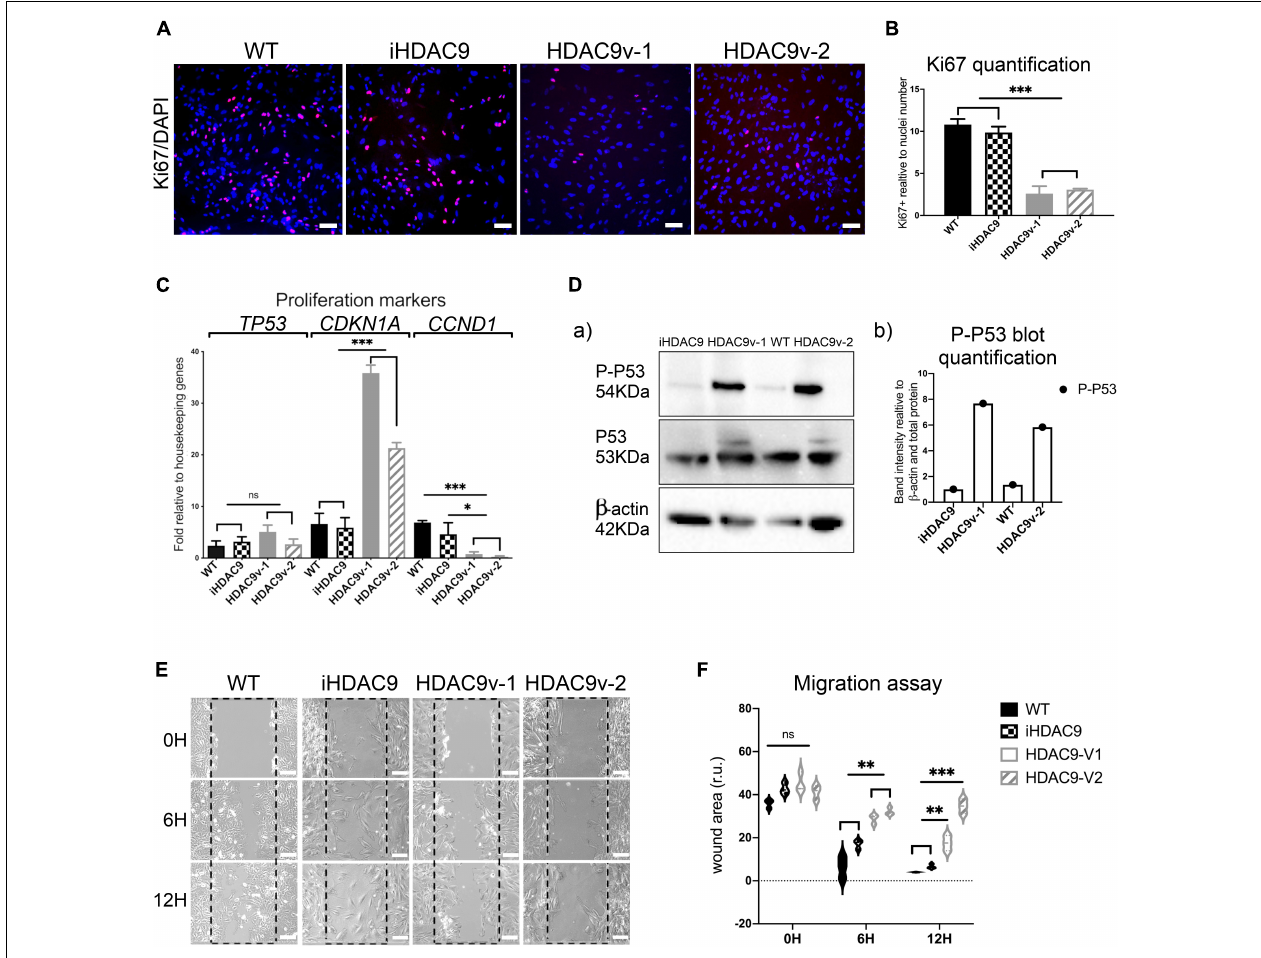
FIGURE 2 | Risk variant HDAC9 hiPSC-derived SMC show lower proliferative rate and migration ability. (A) Ki67 staining was used to measure the proliferation rate of WT1, iHDAC9, HDAC9v-1 and HDAC9v-2 SMC and nuclear counterstaining was performed with DAPI. (B) Quantification of Ki67 staining was expressed relative to cells number (nuclei). (C) mRNA expression analysis of TP53 (P53) CDKN1A (p21), CCND1 (CYCLIN D1) in WT ( n = 3), iHDAC9, HDAC9v-1, and HDAC9v-2 SMC. (D) Cropped blot of phospho-p53 (P-P53), total P53 and β -actin control for WT1, iHDAC9, HDAC9v-1 and HDAC9v-2 SMC (a) and quantification (b); (E) Representative images of scratch wound assays for WT1, iHDAC9, HDAC9v-1 and HDAC9-v2 SMC lines at the indicated time points (0, 6, and 12 h), and (F) quantification of the wound areas. Scale bar = 100 µ m. The results are presented as means ± SD of three independent experiments. ∗ P < 0.05; ∗∗ P < 0.01; ∗∗∗ P < 0.001; ns, not significant. Statistical analysis was performed by 1-way (B,C) and 2-way (F) ANOVA with Tukey’s multiple comparison